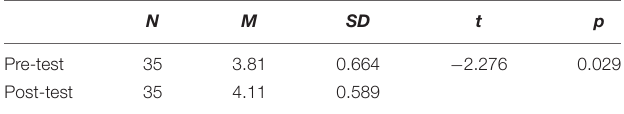
TABLE 6 | The paired sample T -test of knowledge sharing.